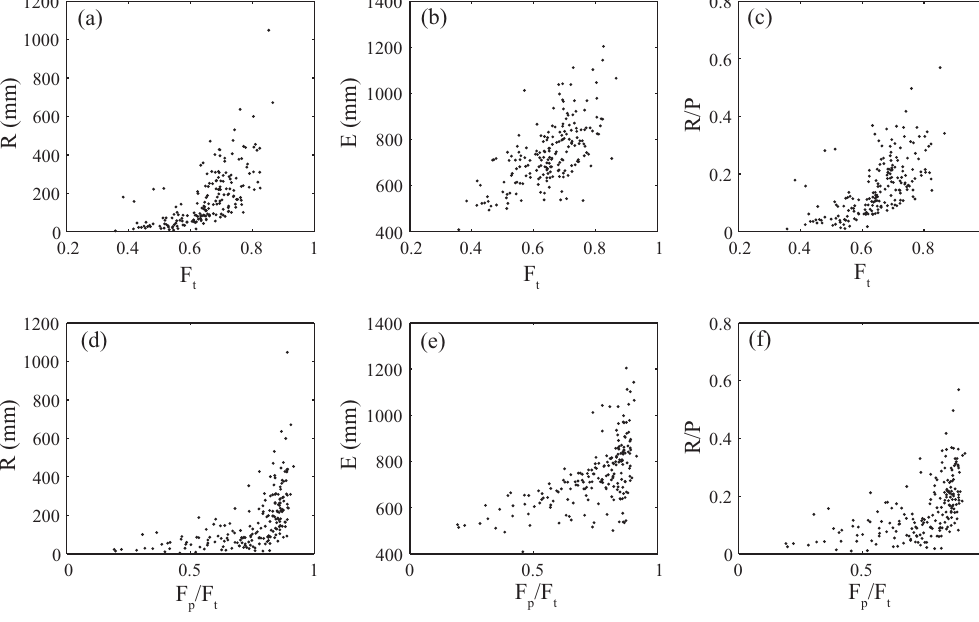
Fig. 6. Scatter plots of mean annual water balance components (total runoff, R and evapotranspiration, E ), mean annual water balance indexes (runoff coefficient, R/P ) against long-term average vegetation cover, including total vegetation (represented by F t ) and fraction of woody vegetation (represented by F p /F t ).